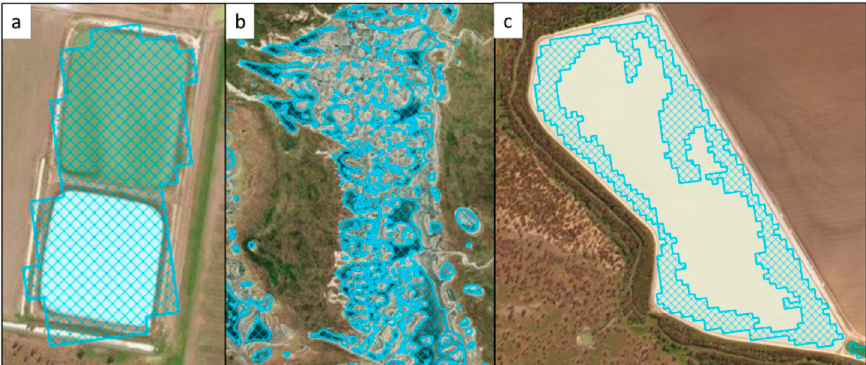
Figure 12. Known limitations with the DEA Waterbodies outlines. ( a ) multiple waterbodies mapped as a single waterbody; ( b ) complex waterbody boundaries resulting in many small polygons rather than a single large polygon; ( c ) incomplete waterbody outlines.